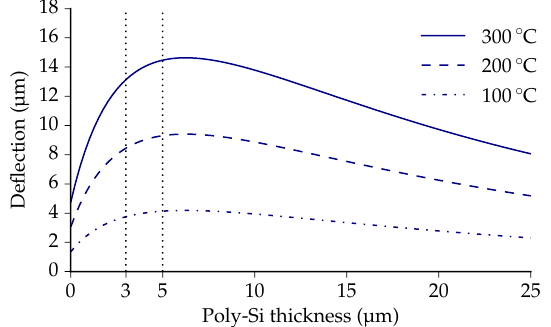
Figure 3. The deflection of the free end of an 800 µm-long, 18 µm-wide single bimorph beam as a function of the poly-Si thickness for a given SiO 2 thickness of 16 µm. The three curves represent different actuator